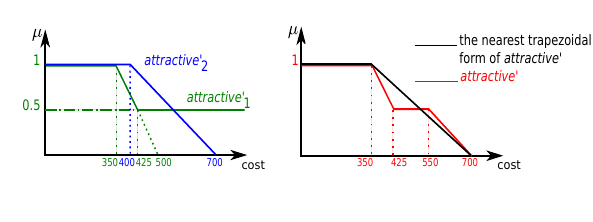
and attractive ′ , attractive ′ 2 1